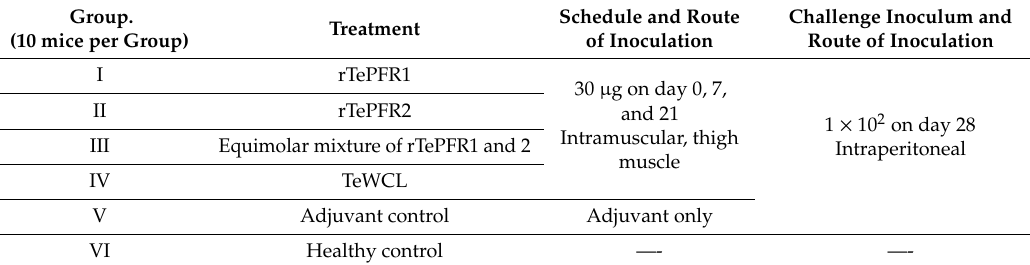
Table 1. Experimental design to assess the immunoprotective potential of rTePFR proteins in mice. The mice in Groups I to III were immunized with 30 µ g of recombinant rTePFR, either singly or in combination, through intramuscular injection in the thigh muscle. The mice in Group IV were immunized with Trypanosoma evansi whole cell lysate (TeWCL) antigen. The proteins were emulsified in FCA (total volume 100 µ L) for primary immunization. The boosters comprised of the proteins emulsified in Freund’s incomplete adjuvant in equal ratio. The mice in Group V were inoculated with the adjuvant alone and served as unimmunized infection controls. The mice were challenged with virulent T. evansi. Mice in Group VI served as healthy controls (unimmunized, unchallenged). Group. (10 mice per